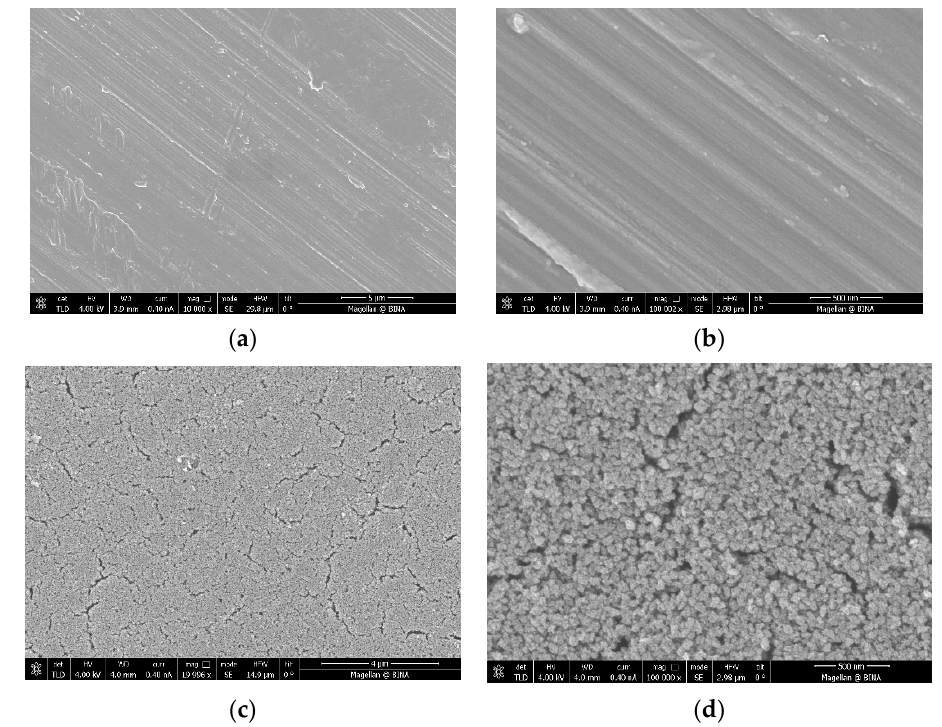
Figure 1. Images taken by high-resolution scanning microscopy (HRSEM) of ( a , b ) a disc before the coating process under low (10 K) and high (100 K) magnification, respectively, and ( c , d ) a coated disc under low (20 K) and high (100 K) magnification, respectively.